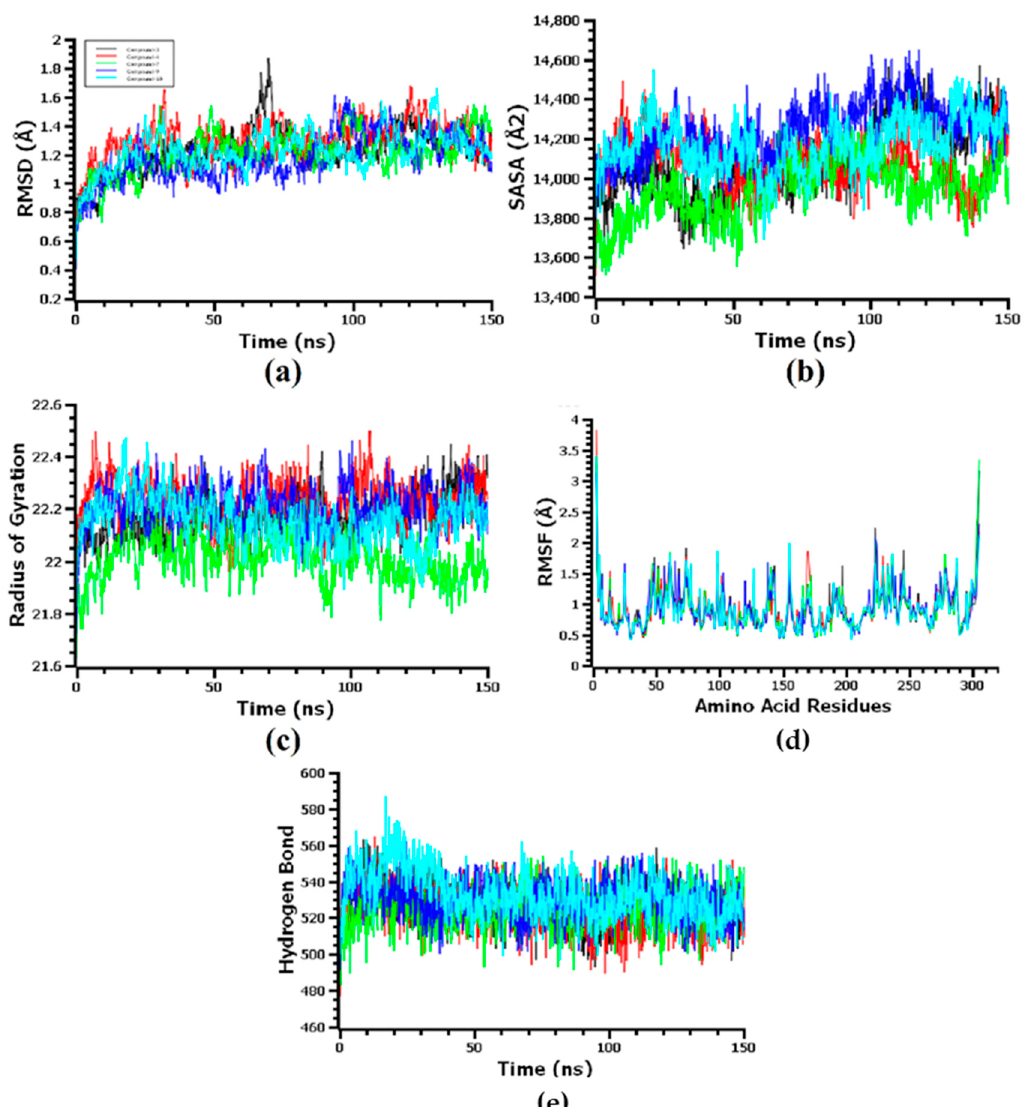
Figure 7. The molecular dynamics simulation trajectories from 150-ns simulation time, here ( a ) root mean square deviation of the C-alpha atoms; ( b ) solvent accessible surface area of the docked complex to understand the change in protein area; ( c ) Radius of the gyration of the complexes ( d ) root mean square fluctuation and ( e ) hydrogen bond of the complexes.